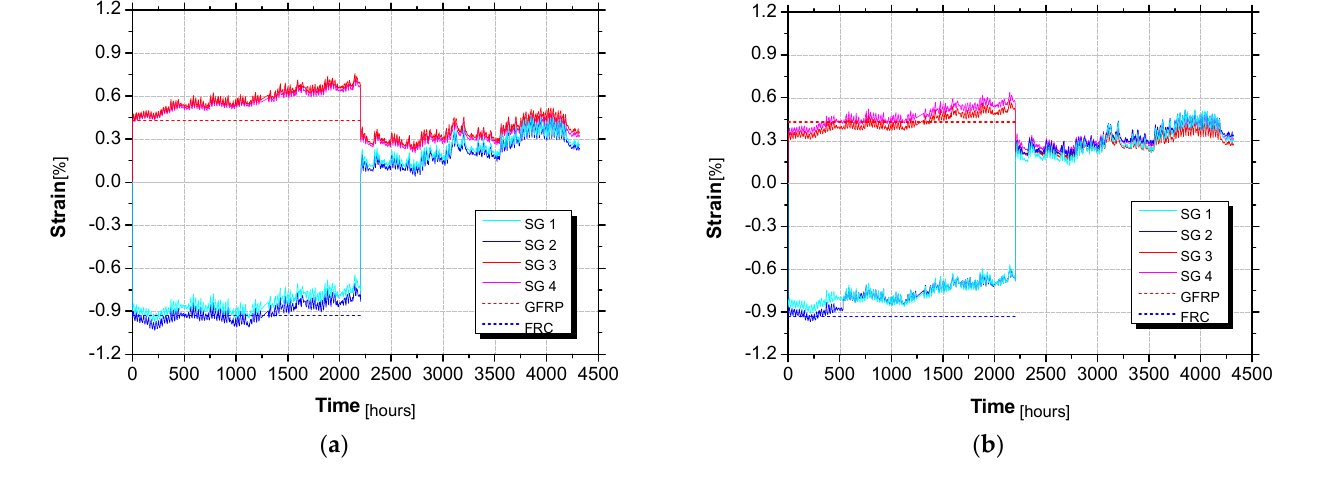
Figure 14. Strain variation for panel ( a ) P3_C and ( b ) P4_C.